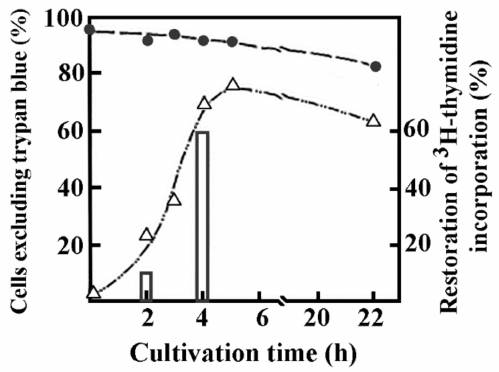
Figure 2. Regeneration of permeabilization tested by trypan blue staining and 3H-thymidine incorpora- tion in murine thymocytes. Mouse thymus cells were permeabilized and then diluted with Parker-199 medium enriched with 10 % human AB serum. Sealing of cells after permeabilization was secured